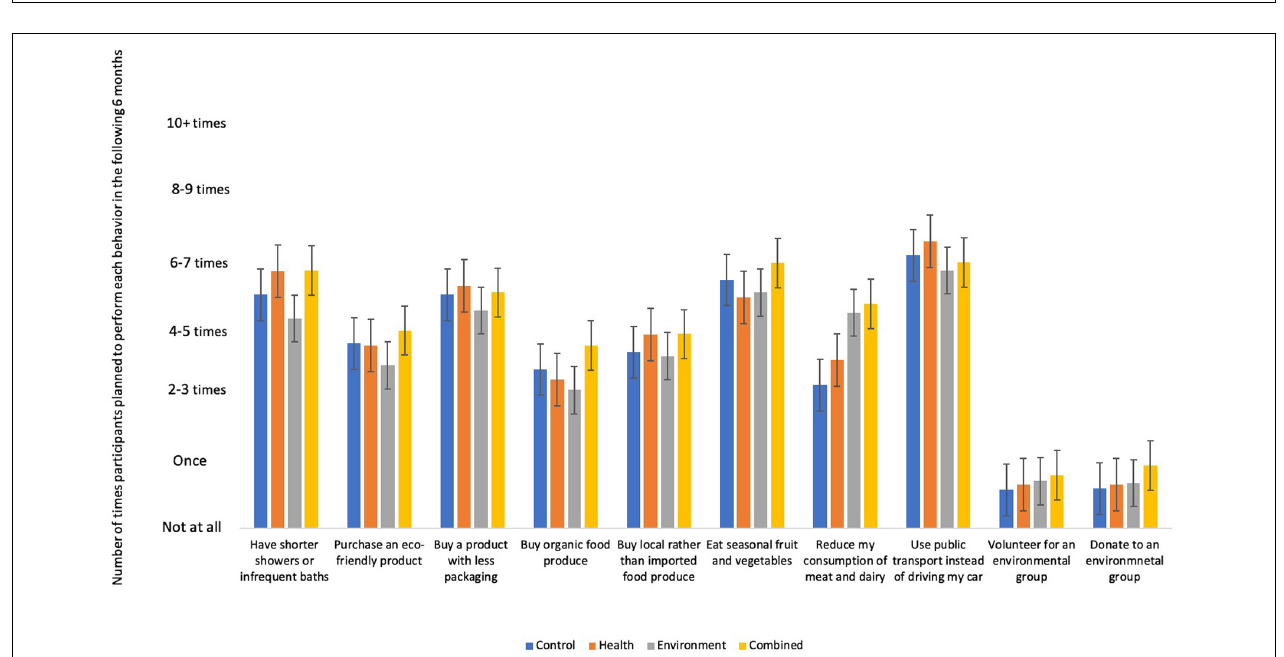
FIGURE 3 | Participants average willingness to perform pro-environmental behaviors at time 3.